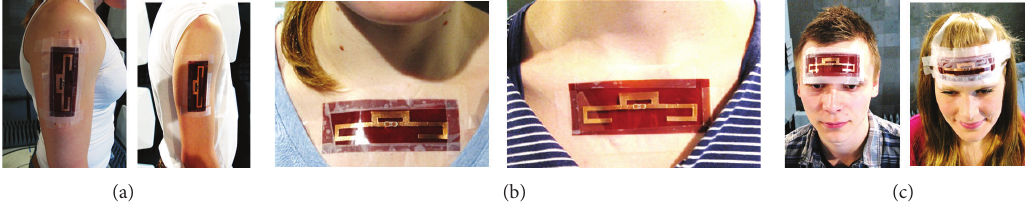
Figure 4: A human body model is evaluated for three different body locations: (a) upper arm, (b) chest, and (c) head. The tag antenna is linearly polarized. The tag is attached to the skin using adhesive tape.